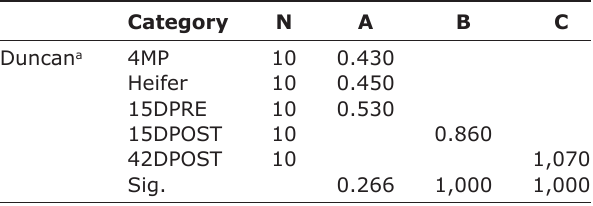
Table-2: Duncan’s test and means subsets formation between the means of blood values of BHB.